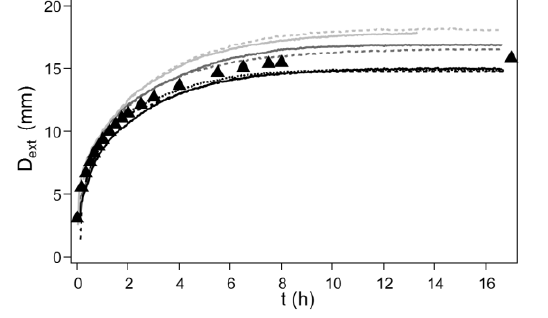
Fig. 3. D Ext of individual growth experiments as a function of time for all cell apertures H. mm. In ▲ the values obtained for the free growth of